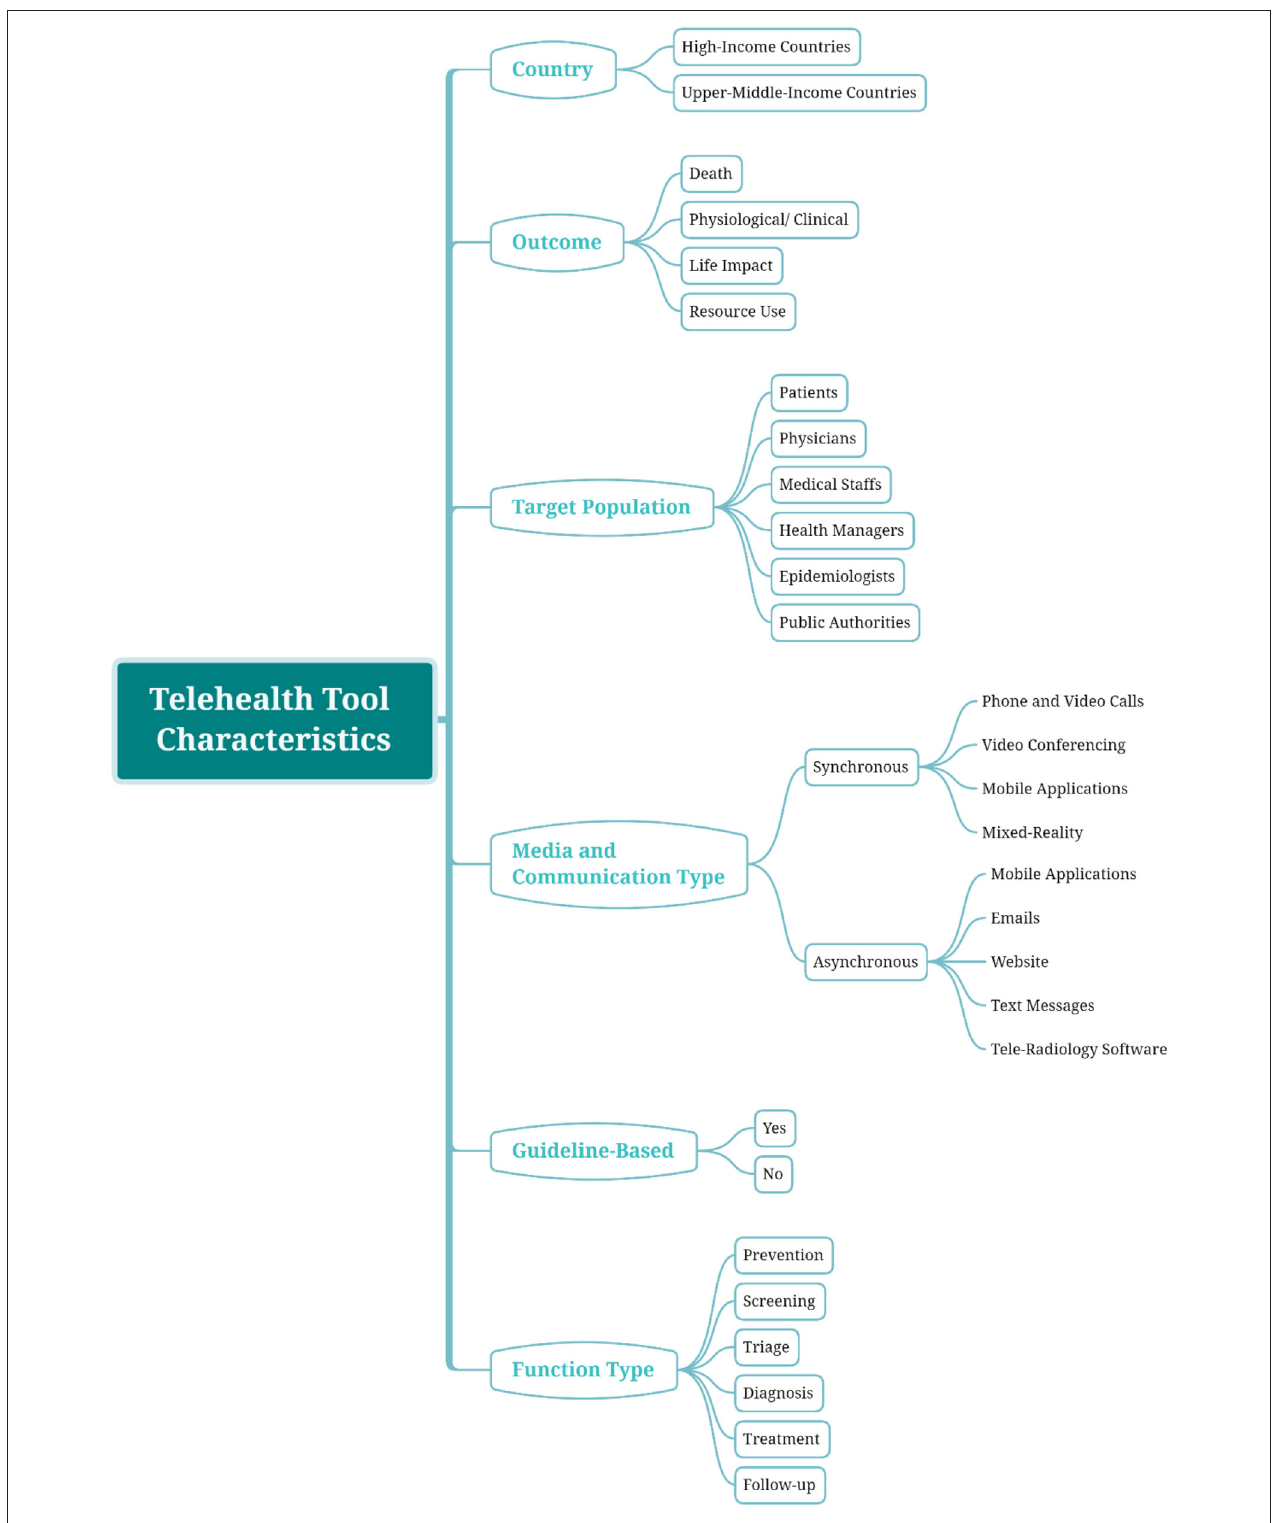
FIGURE 2 | Classification map; an overview of the identified categories in each aspect.